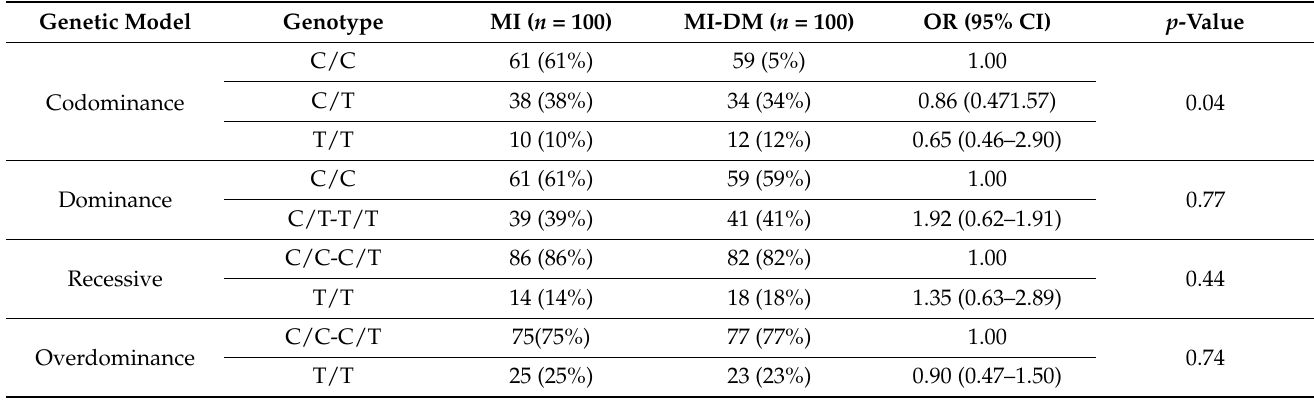
Table 7. Association of MTHFR C677T (rs1801133) single nucleotide polymorphism in myocardial infarction (MI) and MI with diabetes mellitus (MI-DM) study groups ( n = 200).